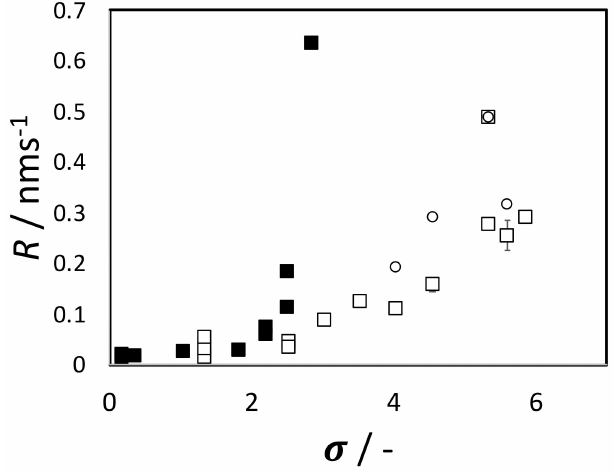
Figure 3. Normal growth rates ( R ) of a {101} face with supersaturation σ . Open and filled squares indicate R values of this and previous [8] studies, respectively. Open circles indicate apparent growth rates ( R’ ) of a crystal nucleated in the solution (described in Section